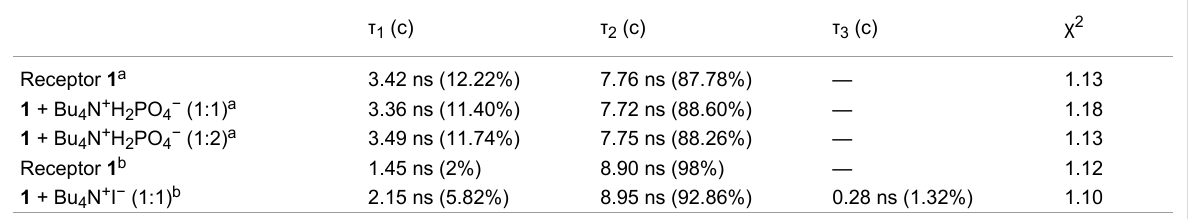
Table 2: Fluorescence decay times ( τ ) and pre-exponential factors (c) for 1 in the presence and absence of anions.